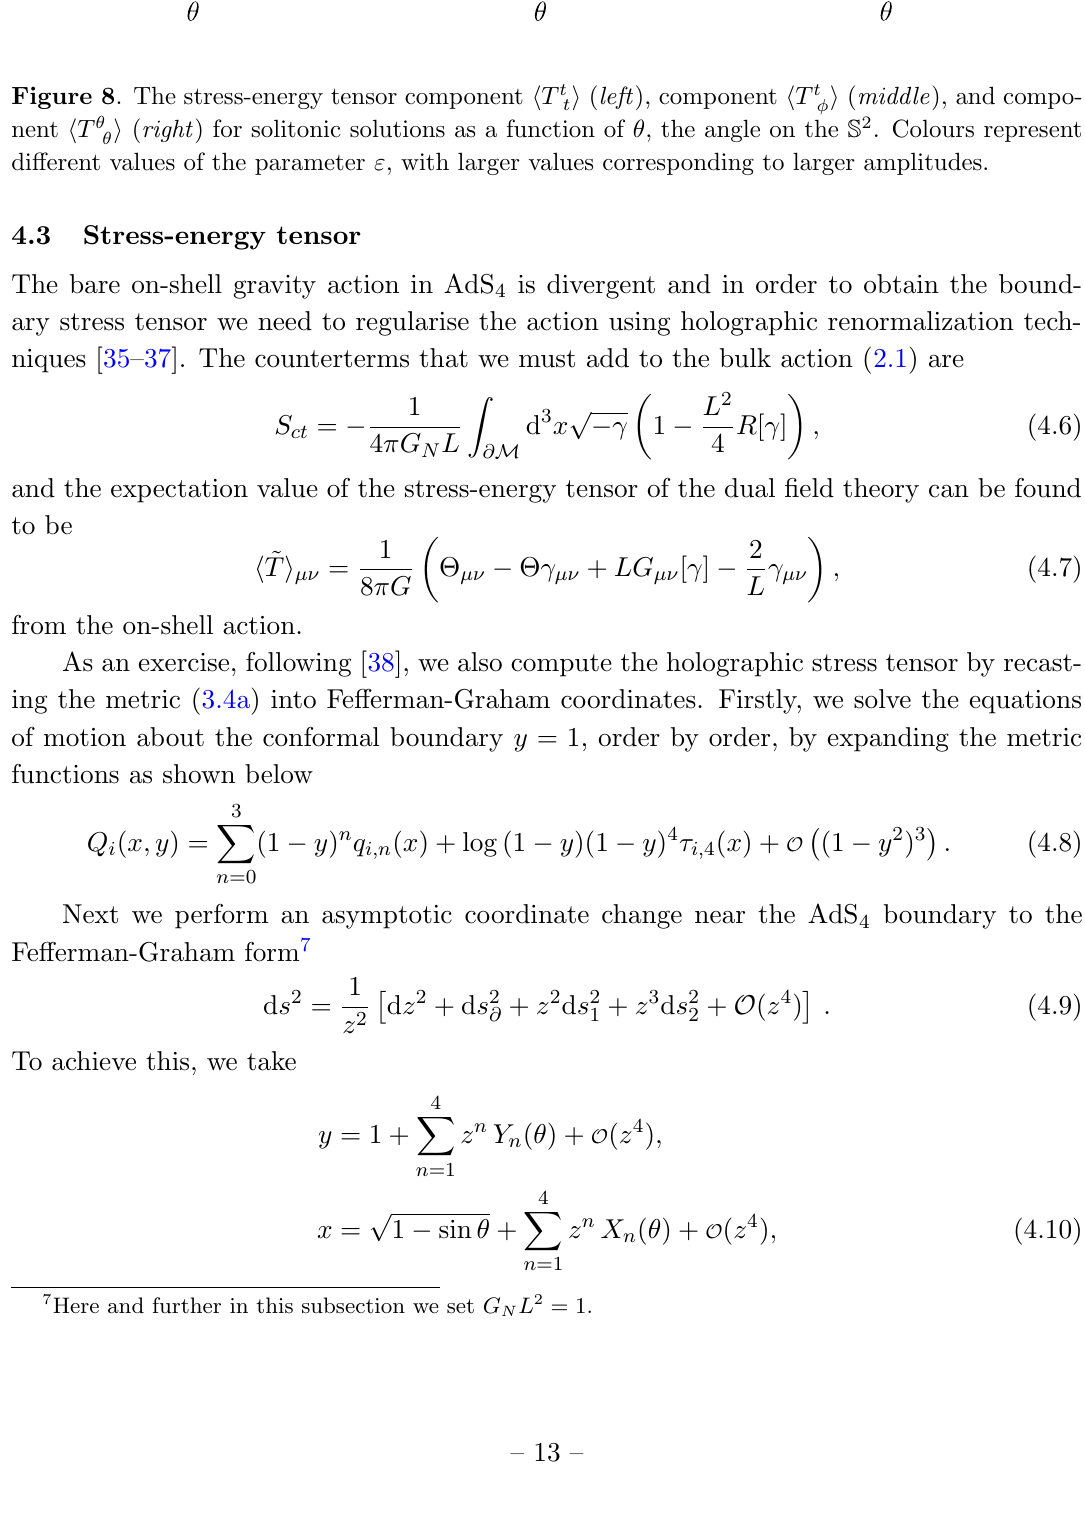
i ( left ), component h T t i ( middle ), and compo- t (cid:30)